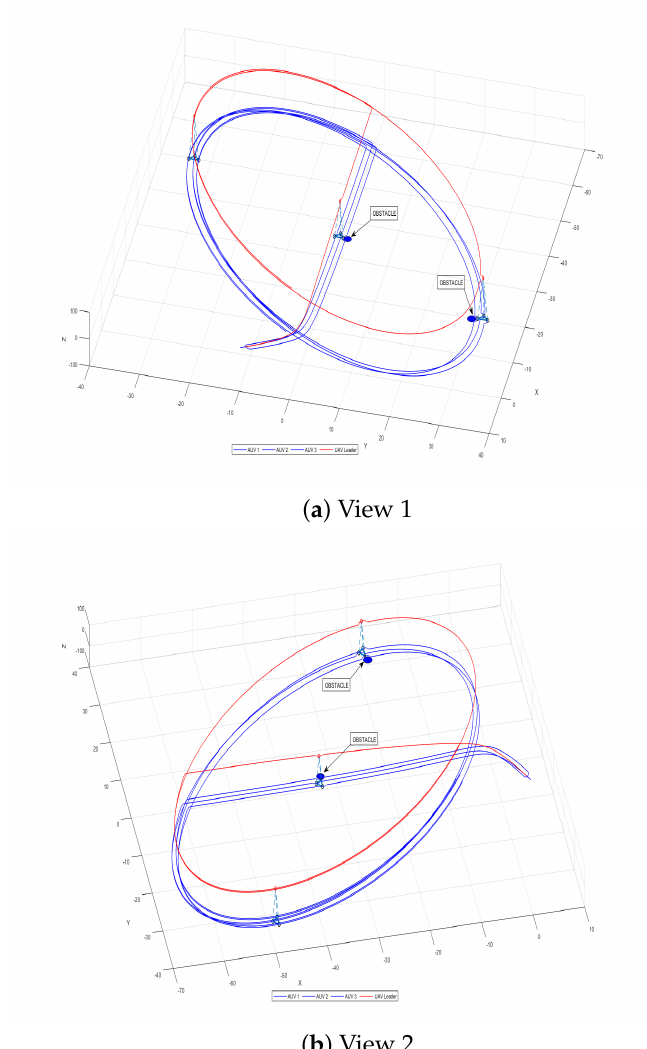
Figure 7. The formation maintenace and control of three AUVs in triangle form with their UAVs leader during obstacle avoidance in 3D